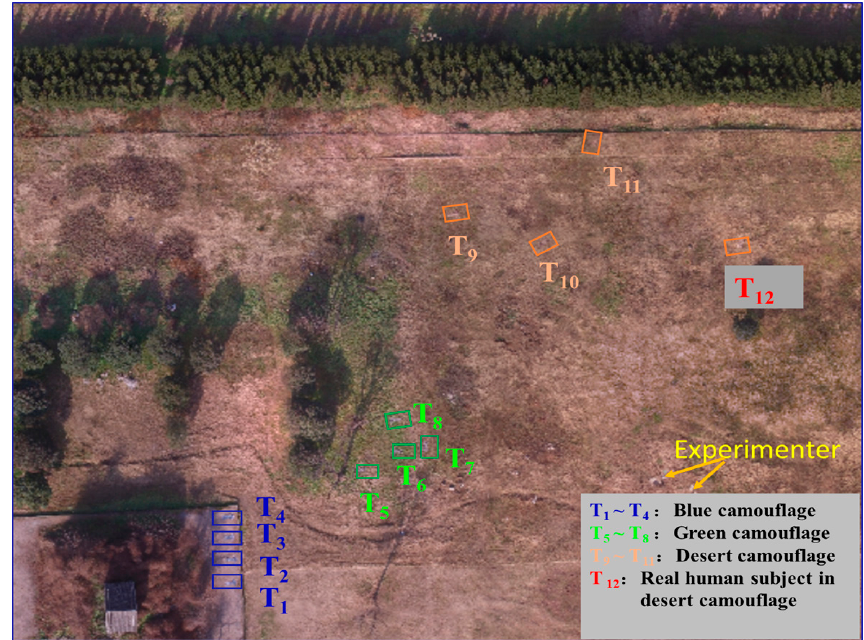
Figure 14. The complete reflectance panorama in Scenario 2.